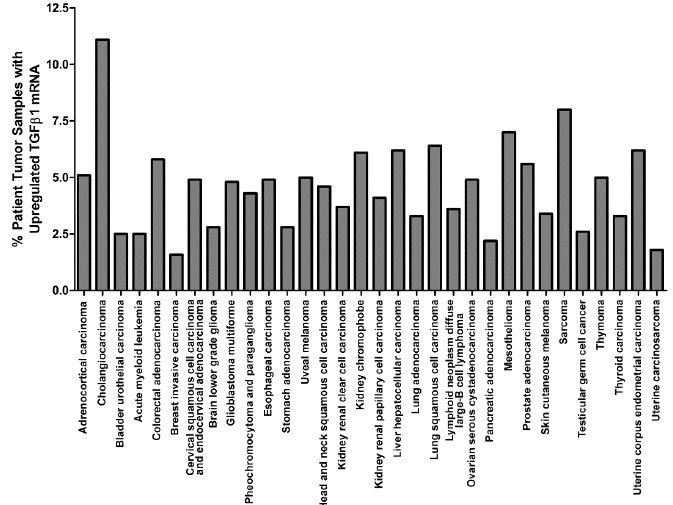
Figure 2. TGF β 1 mRNA upregulation in tumor samples as determined by RNA Seq V2 RSEM (z-score threshold = 2.0). Results were obtained from an interrogation of TCGA, provisional data on 5 June 2016 and are based on data generated by the TCGA Research Network: http://cancergenome.nih.gov/.